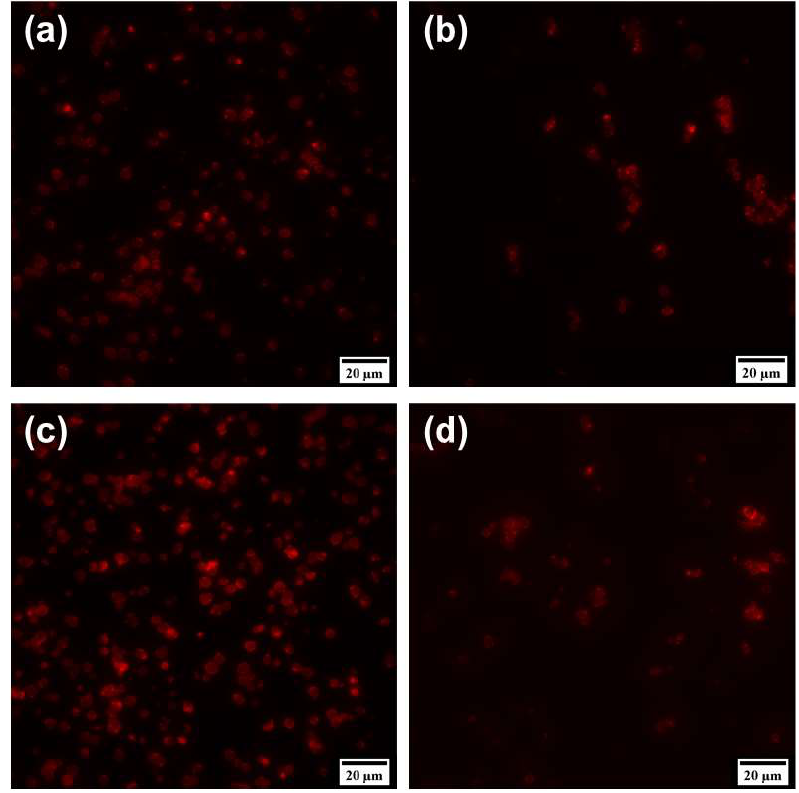
Figure 5. Fluorescence microscopy images of the polyelectrolyte microcapsules, optically encoded with quantum dots alone, ( a ) before, and ( b ) after dissolution of the calcium carbonate microbeads and dually doped both with quantum dots and doxorubicin, with ( c ) the drug encapsulated in the calcium carbonate microbeads and ( d ) the drug encapsulated into hollow microcapsules.